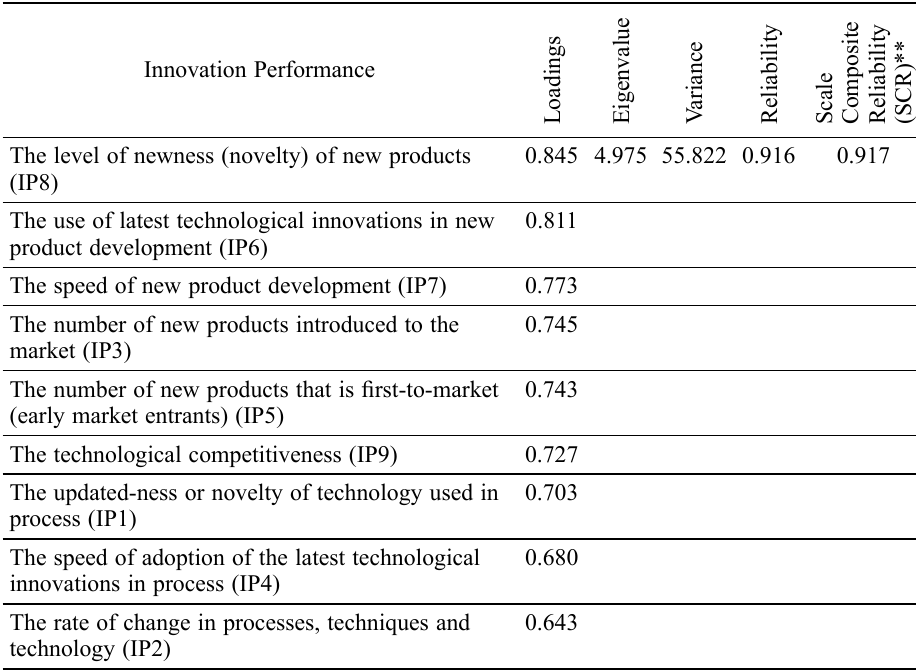
Table 3. Factor analysis of innovation